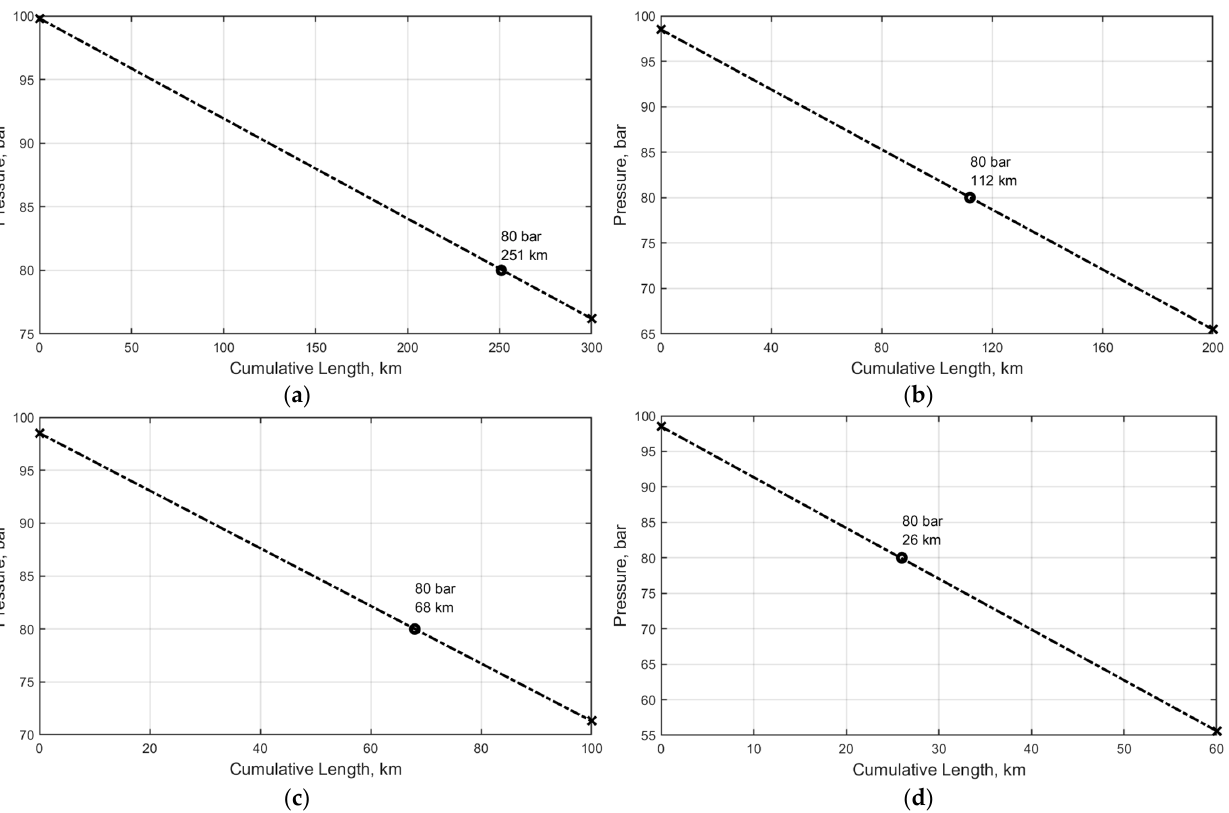
Figure 6. The distance over which the minimum operating pressure for a variant pipeline diameter will reach the 80 bar limit for X70 steel. ( a ) 16-inch diameter pipeline; ( b ) 14-inch diameter pipeline; ( c ) 12-inch diameter pipeline; ( d ) 10-inch diameter pipeline.